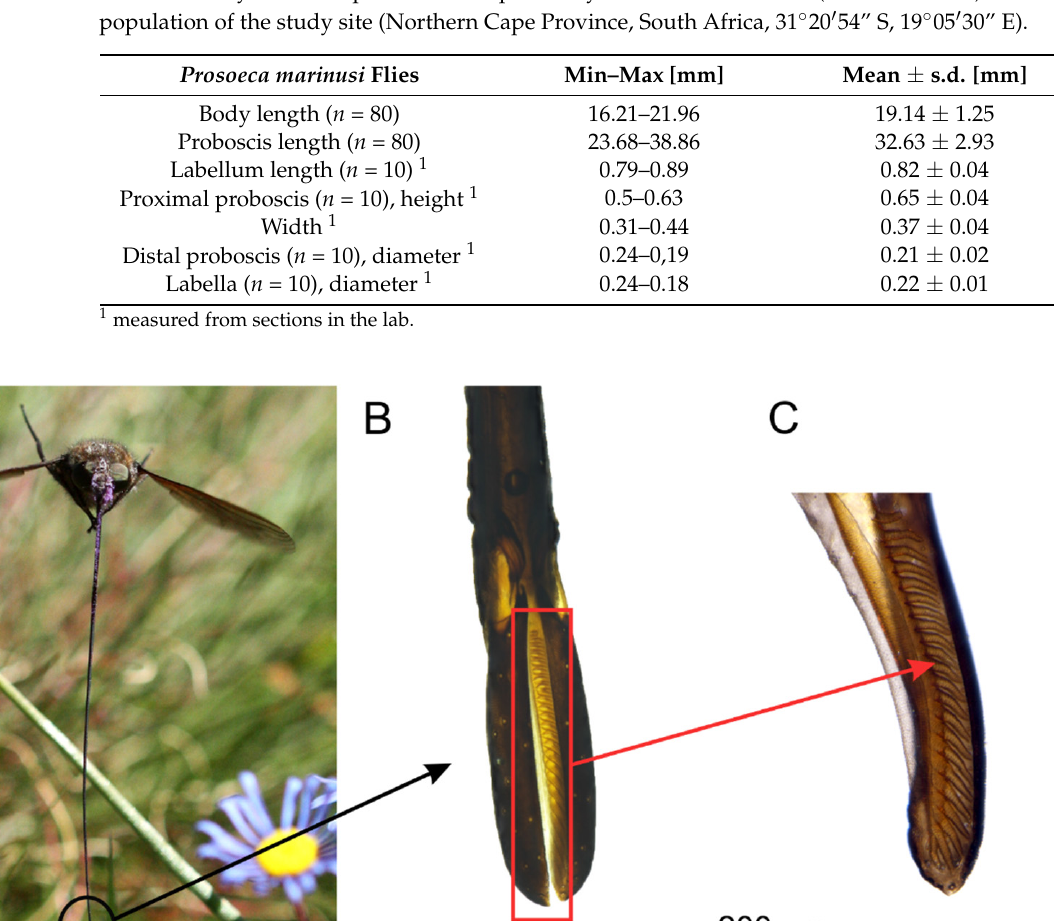
Table 1. Body size and proboscis morphometry of Prosoeca marinusi (Nemestrinidae) from the